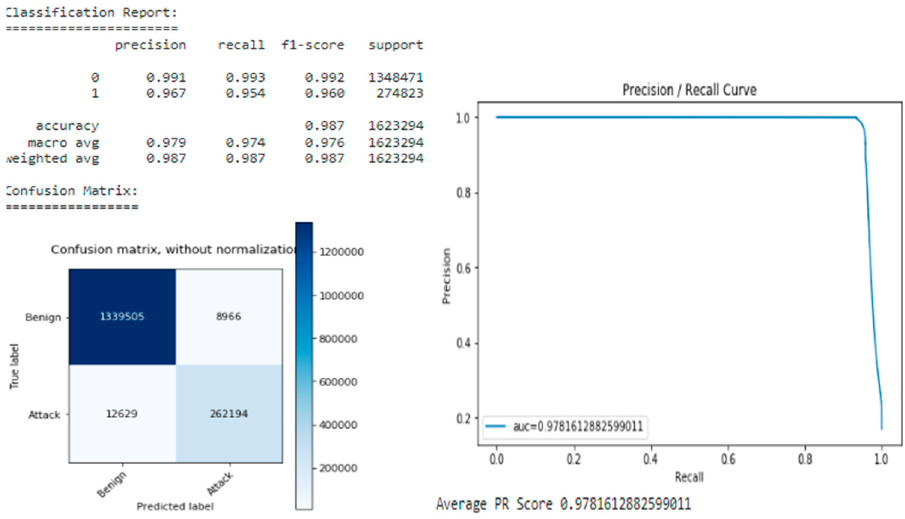
Figure 16. Model with Optimal Parameters.